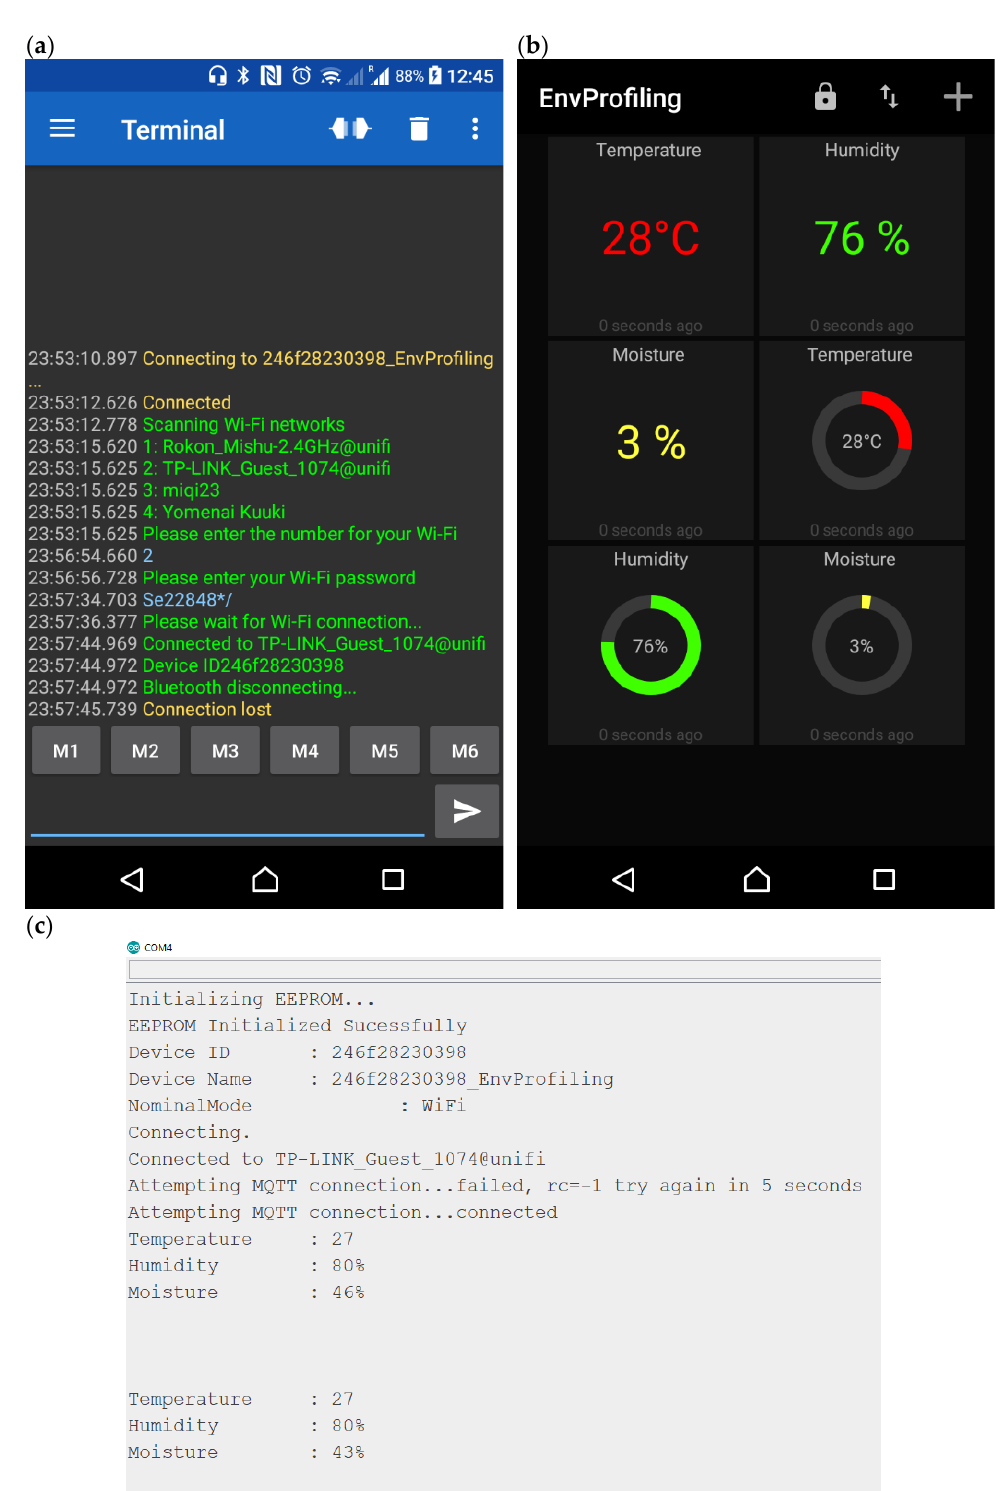
Figure 14. IoT features developed for the HEHS prototype ( a ) connection established to the smartphone; ( b ) MQTT dashboard to monitor sensor data; ( c ) sensor data transmitting to the serial monitor of laptop or cloud server.